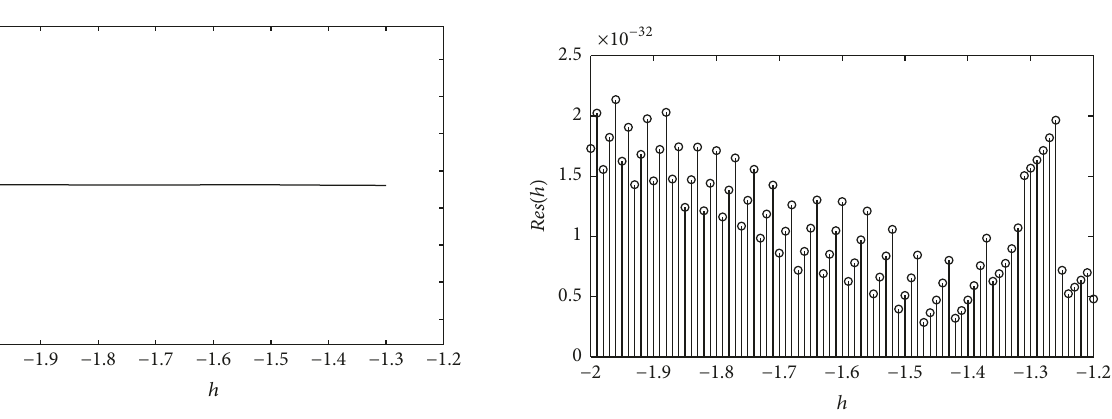
Figure 1: The valid region of ℎ for the explicit spectral PIM when 𝑁 = 15 for Example 1.